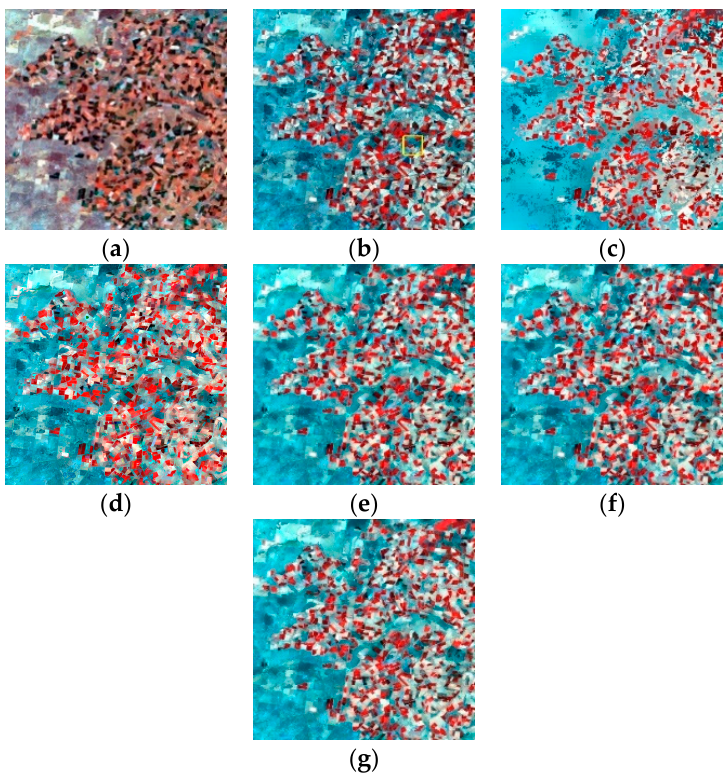
Figure 5. Original Landsat images on December 25, 2001 ( a ) and January 12, 2002 ( b ), and the images predicted by Unmixing-Based Data Fusion (UBDF) ( c ), FIT-FC ( d ), FSDAF ( e ), SFSDAF ( f ) and adaptive-SFSDAF ( g ).